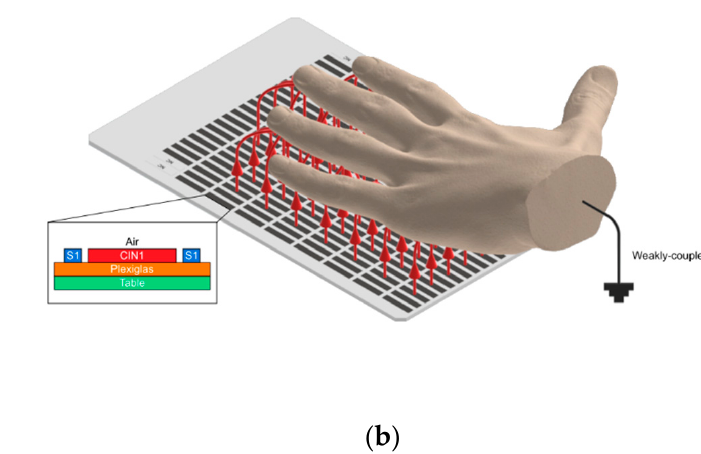
Figure 2. Sensor Board: ( a ) The Sensor Board; ( b ) Illustration of the loading mode